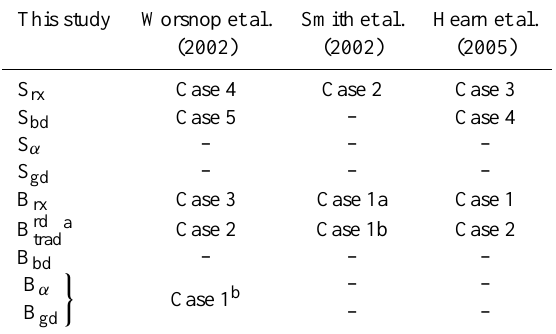
Table 6 for two different points in reaction